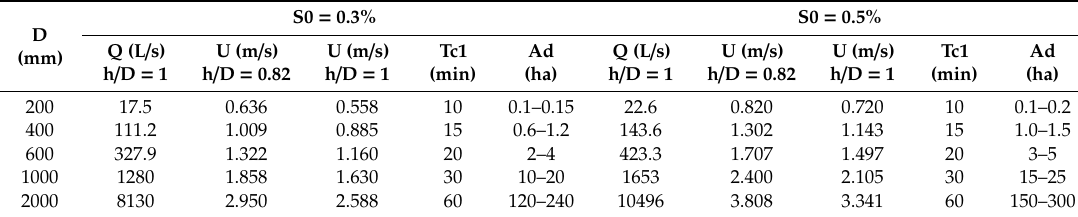
Table 1. Volumetric flow rates at full section (peak flow of the symmetric triangular hydrograph of base 2Tc1), average velocities in the transversal section, and estimates of the magnitude of times of concentration and drainage basin areas served for several pipe diameters and sewer slopes of 0.3